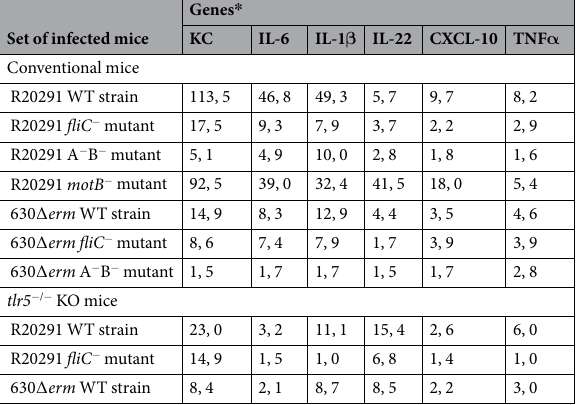
Table 1. Fold expression of pro-inflammatory cytokine encoding genes of C. difficil e-infected mice. * The mean Ct from each group is reported to those of the negative control and with the expression of the GAPDH gene for each